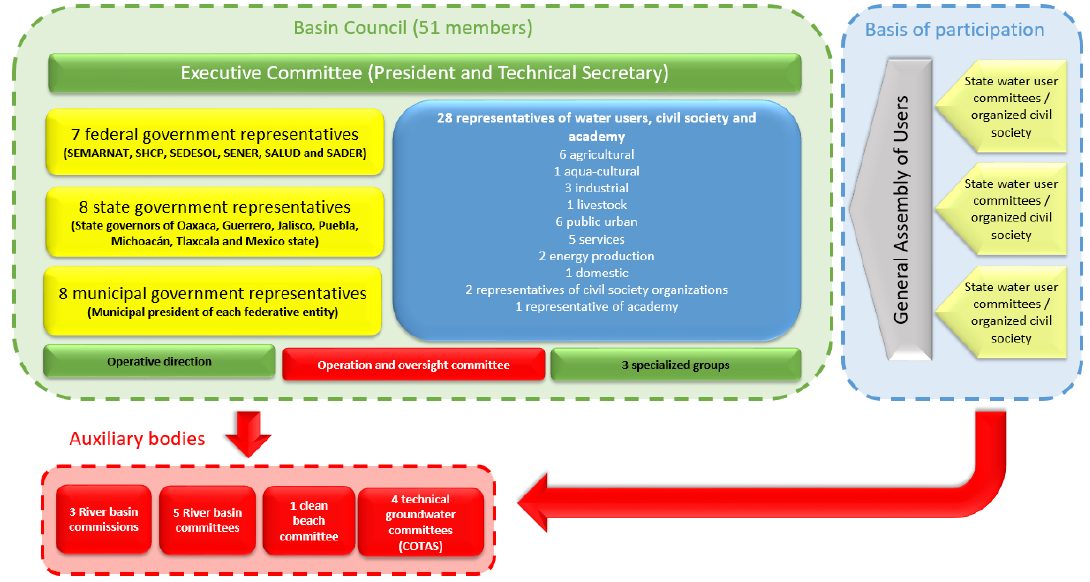
Figure 2. Structure of the Balsas River Basin Council. Source: own compilation.